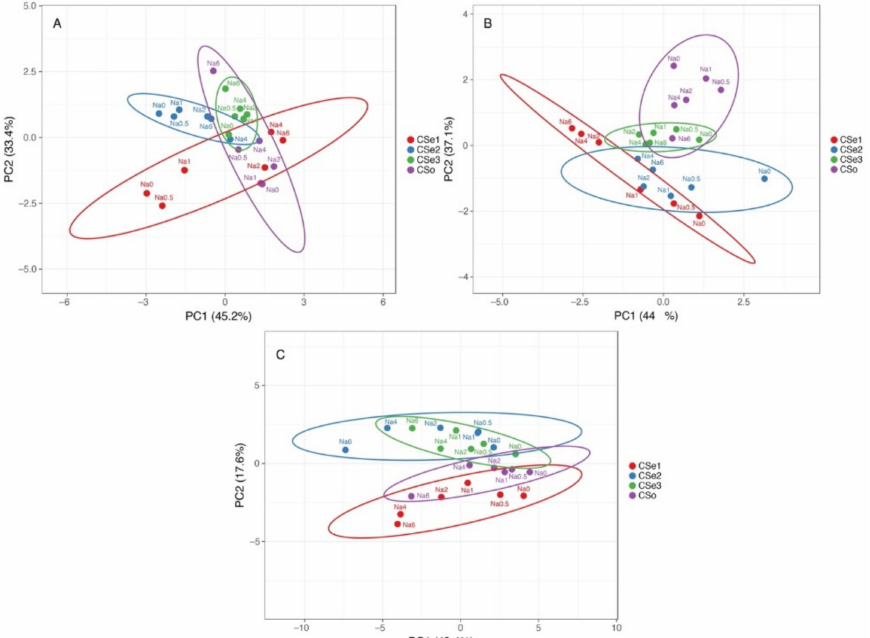
Figure 12. Principal component analysis on effect of increasing soil salinity on morphological parameters ( A ), biomass partitioning ( B ) and ion accumulation ( C ) in Calystegia sepium accessions CSe1, CSe2, CSe3 and Calystegia soldanella (CSo) plants. Prediction ellipses are such that with probability 0.95, a new observation from the same group will fall inside the ellipse. Unit variance scaling was applied to rows; singular value decomposition with imputation was used to calculate principal